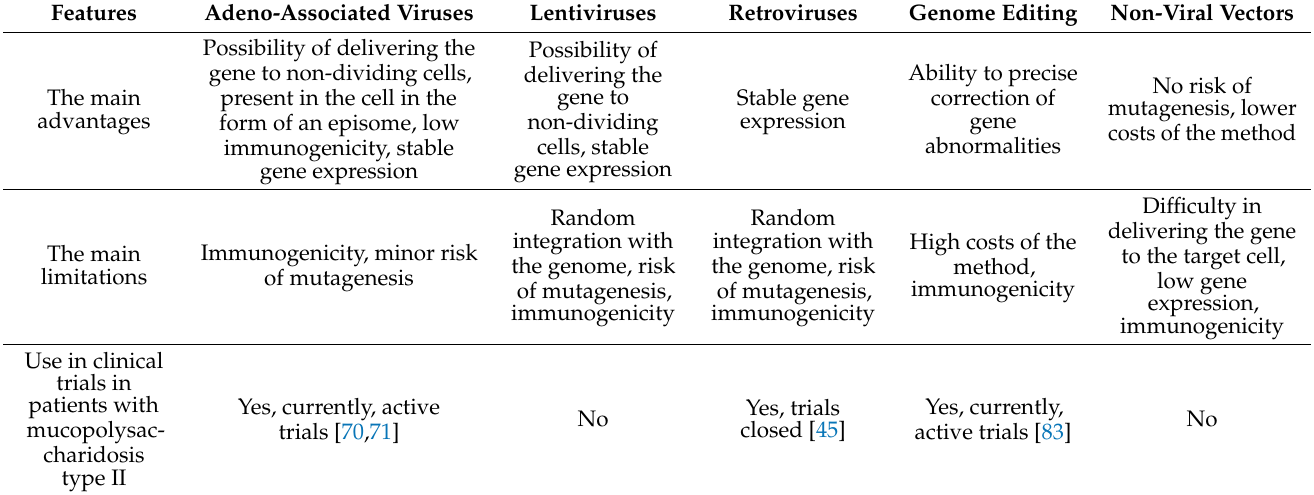
Table 2. Comparison of current methods of gene therapy in mucopolysaccharidosis type II.